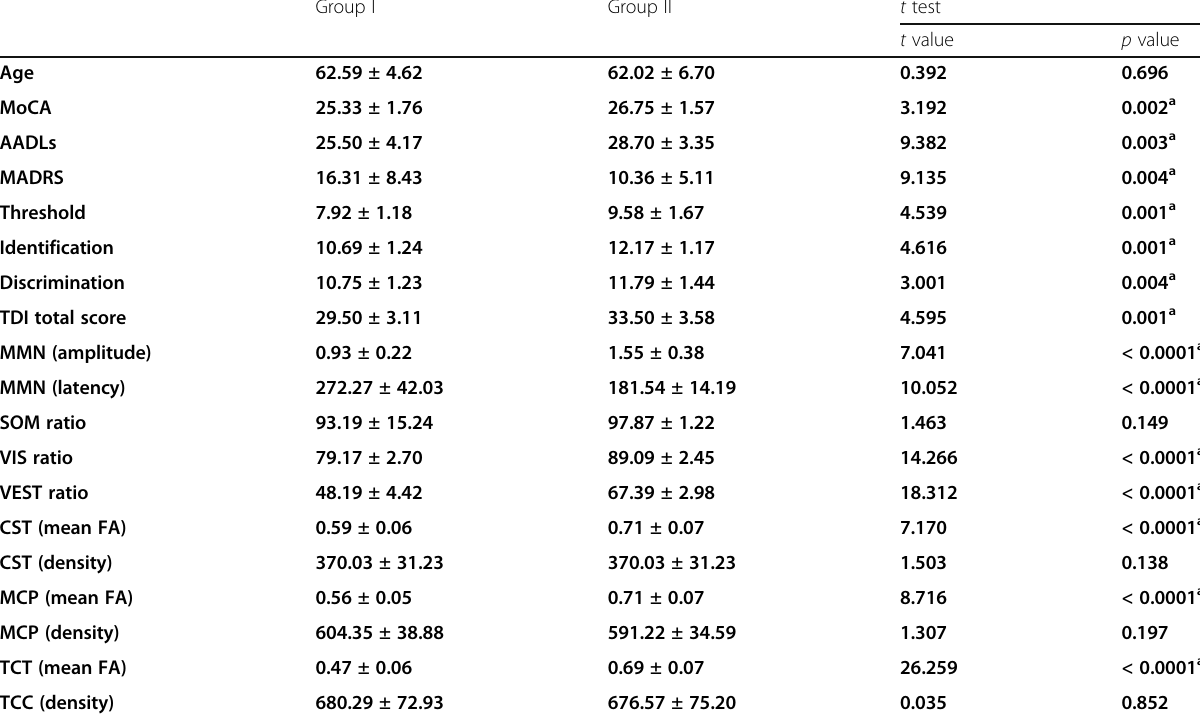
Table 1 Comparison between essential tremor patients (group I) and healthy control subjects (group II) regarding the non-tremorgenic